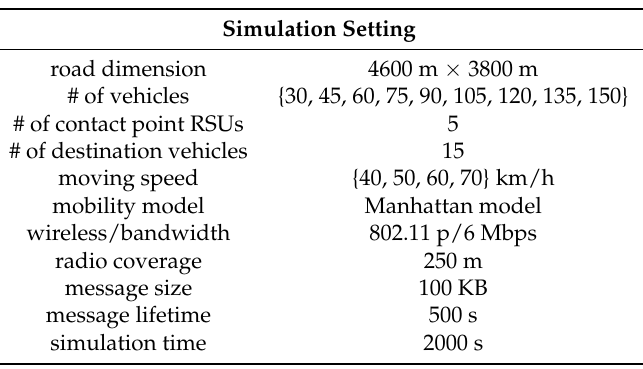
Figure 4. Road configuration for simulation. Table 2. NS-2 simulation